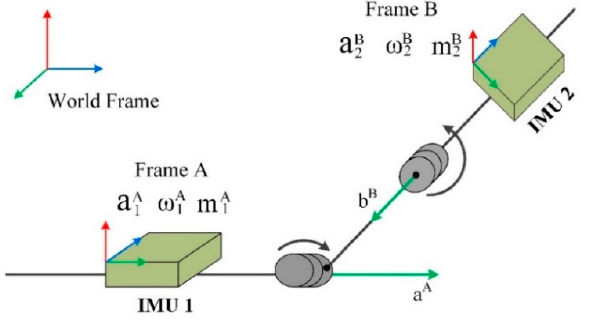
Figure 4. Kinematic model of elbow joint.